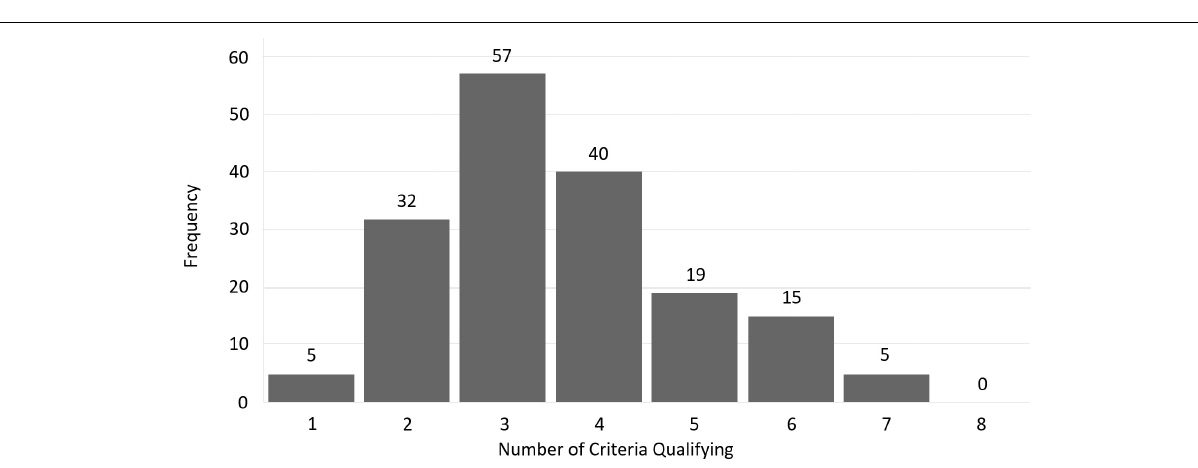
FIGURE 6 | Frequency of multiple IMMA selection criteria being observed to be used in any single IMMA identified (5 IMMAs identified on basis of single criterion, 168 IMMAs identified using between 2 and 7 different criteria, and no IMMAs identified on the basis of all 8 different selection